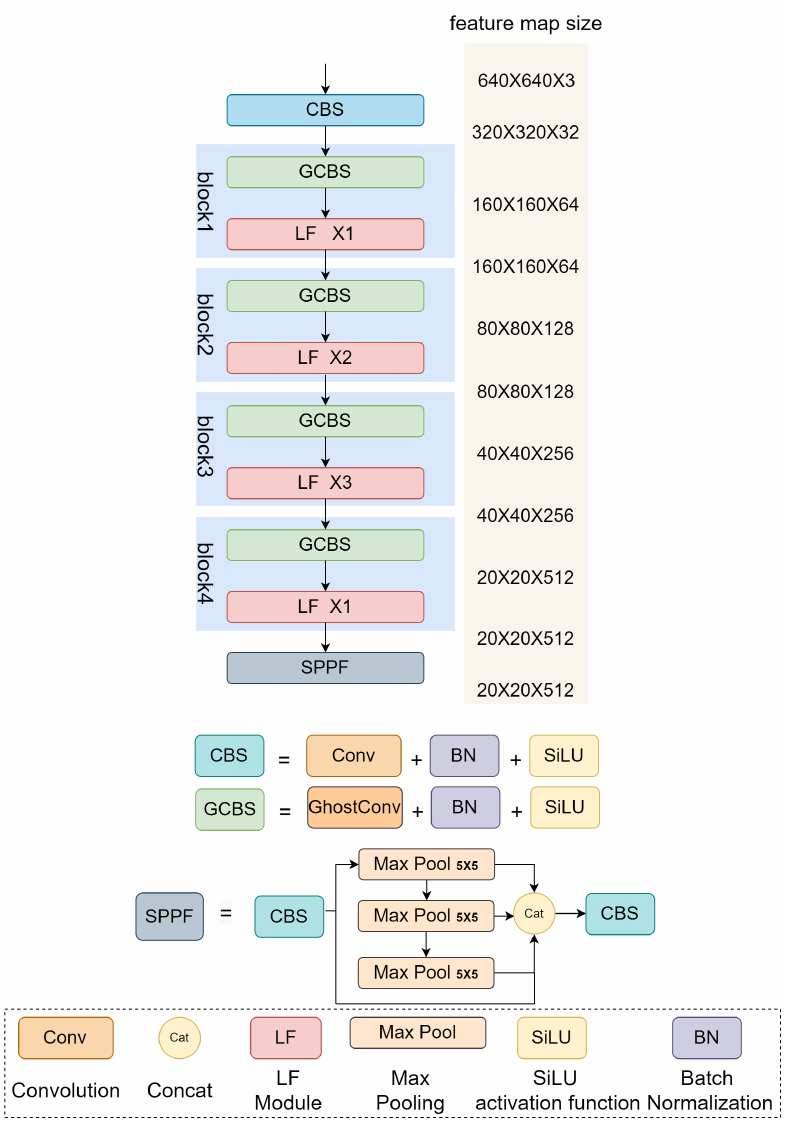
Figure 3. Backbone Structure. The left part is the structure of the backbone, and the right part is the size and number of channels of the output feature map of each